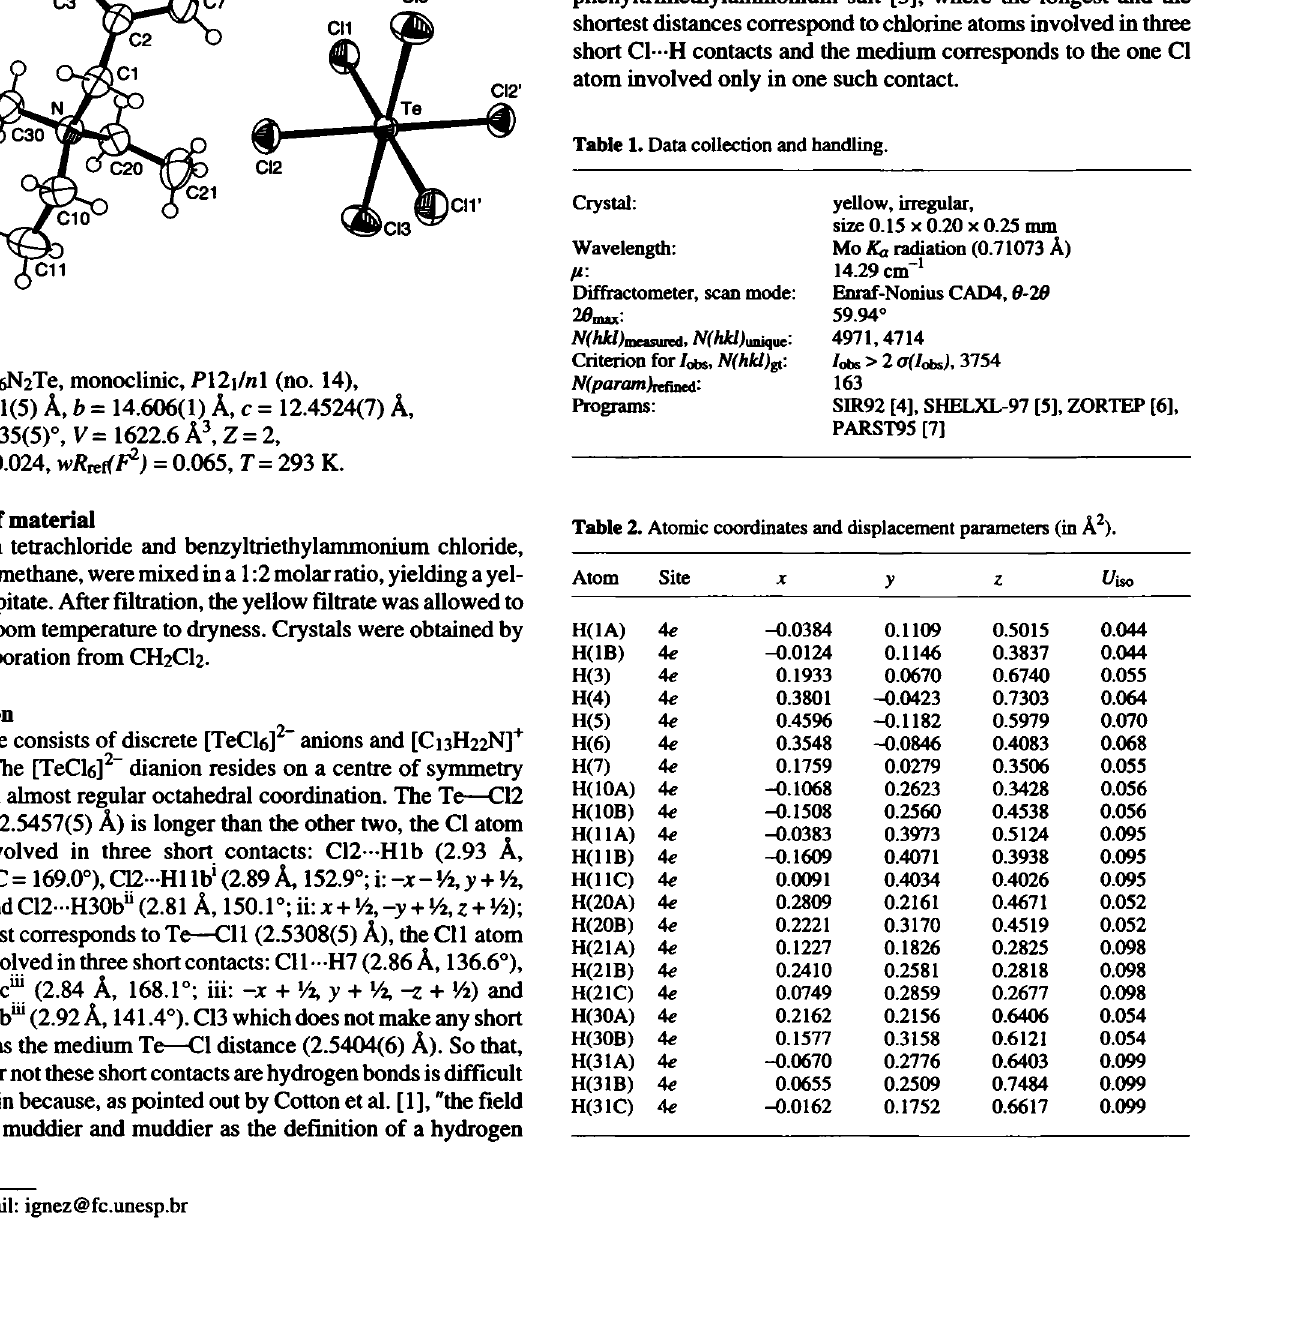
Table 1. Data collection and handling.